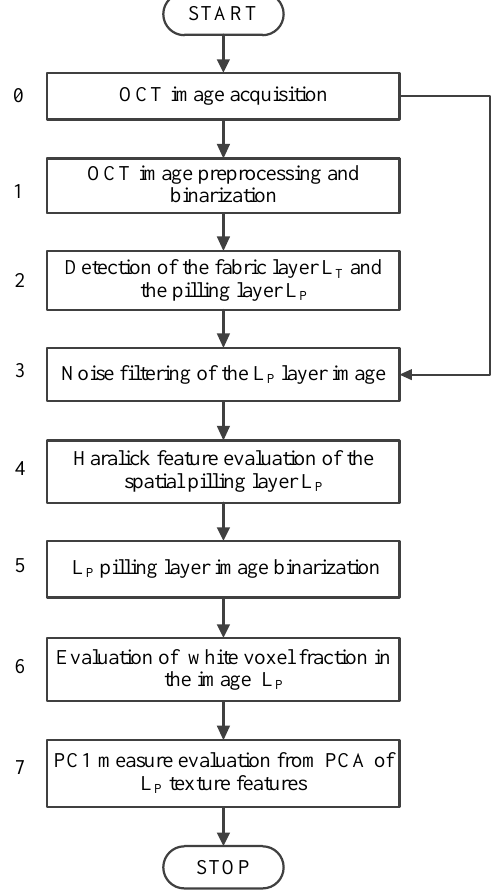
Figure 3. Flowchart of the proposed